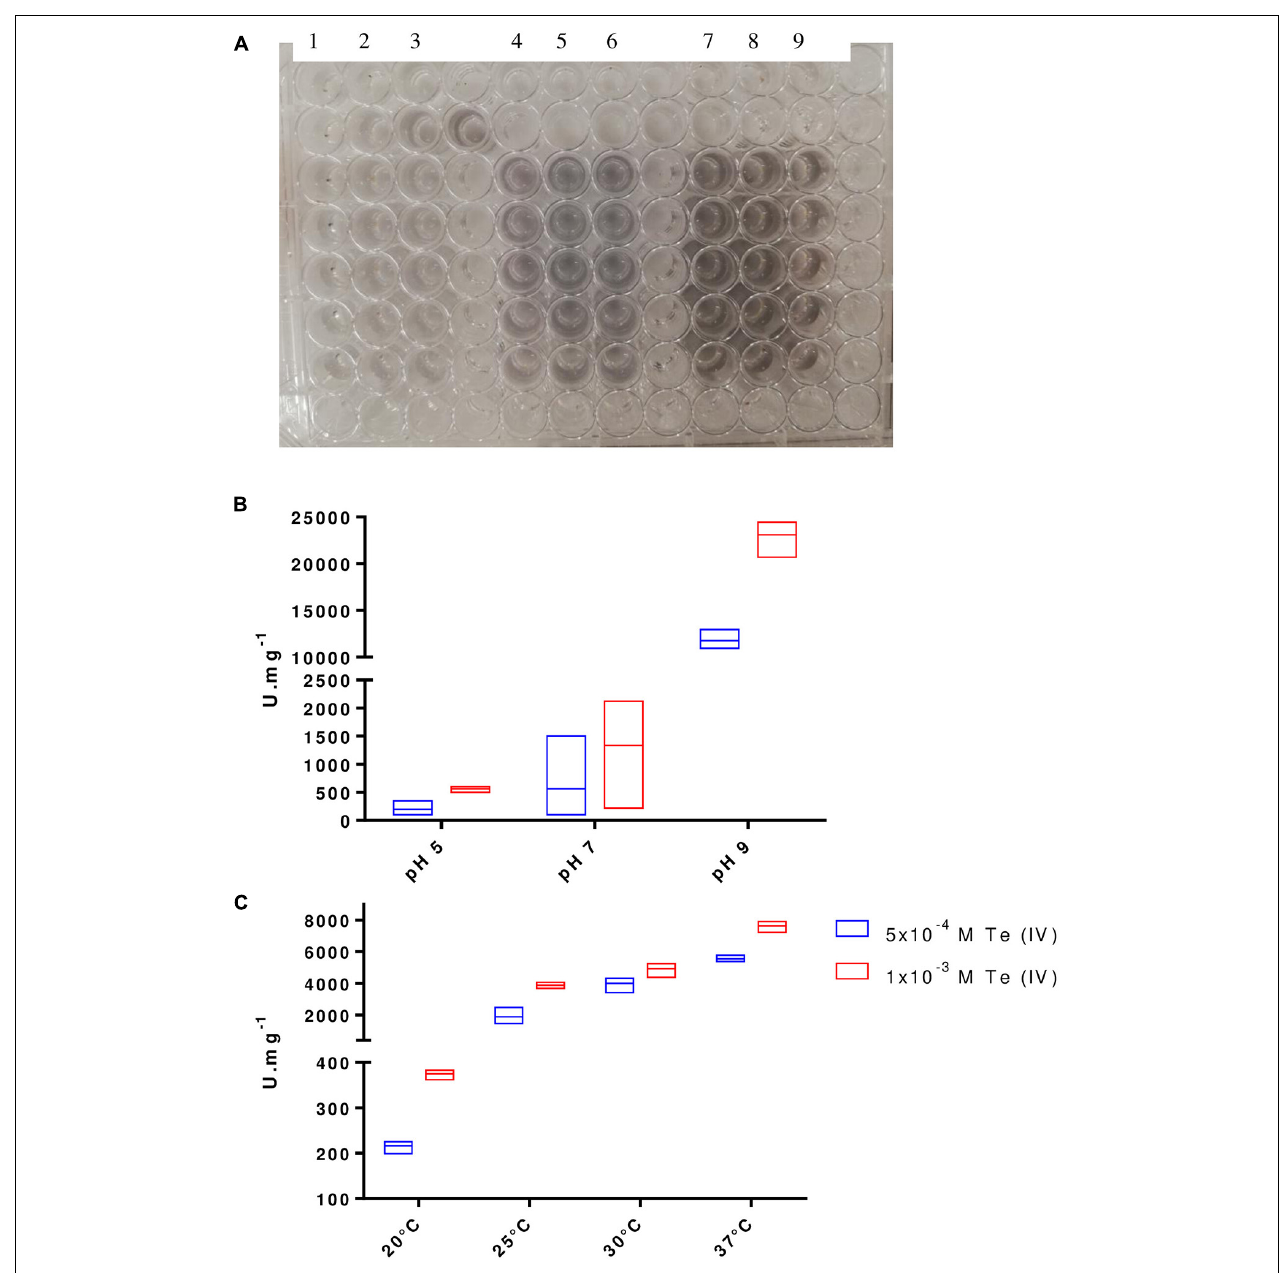
FIGURE 6 | Te (0) formation by FlaA. (A) Te (0) formation visible by the appearance of black precipitates in each reaction mixture (individual wells). Test conditions represented Control—columns 1, 2, 3; 5 × 10 − 4 M Te (IV)—columns 4, 5, 6; and 1 × 10 − 3 M Te (IV)—columns 7, 8, 9. Optimal pH (B) and temperature (C) of Te